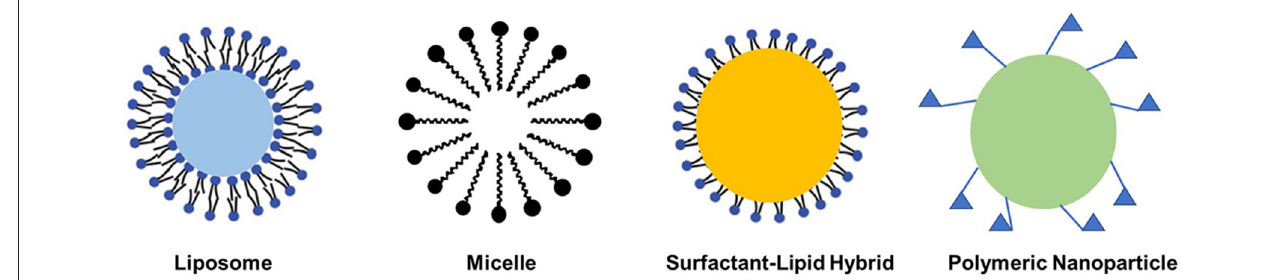
FIGURE 2 | Types of soft material nanoparticle-based delivery systems for inner ear drug delivery.